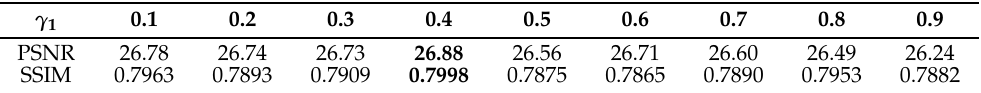
Table 9. Mean metrics comparisons of different γ 1 , γ 2 on the PatternNet dataset. The bold values denote the best results.